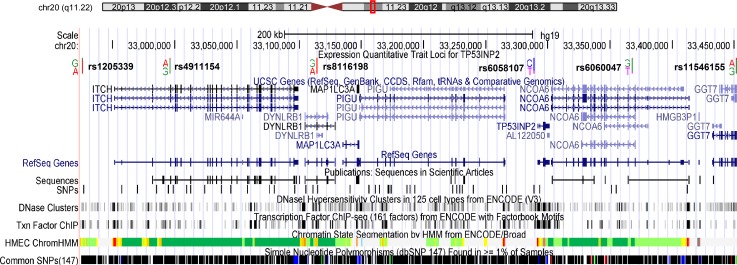
The 20q11.22 locus spanned for expression quantitative trait loci of TN53INT2, and analysis of regulation enhancer with data from ENCODE through UCSC Genome Browser, including transcription factor binding sites and human mammary epithelial cells (HMEC) histone modification marks.Chromosomal coordinates are in NCBI build 37.